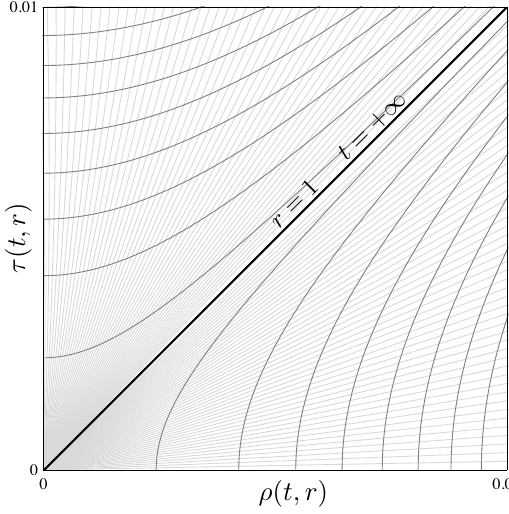
Figure 2 . (cid:28) ( t; r ) and (cid:26) ( t; r ) in units of r g . Lines of constant r are dark gray and lines of constant t are light gray. The horizon is at (cid:28) ( t; r ) = (cid:26) ( t; r ). (cid:12) 1 =(cid:12) 2 is set to 1. at the horizon, i.e., when r = r g and tanh[ t= 2 r g ] = 1. In other words, we are enforcing that the horizon be a null surface in the ( (cid:28); (cid:26) ) coordinates of the reference metric. These two conditions (cid:12)x all integration constants at each order in n . We plot the solution in (cid:12)gure 2. The dark gray lines are lines of constant r and the light gray lines are lines of constant t . The horizon corresponds to (cid:28) = (cid:26) . Outside the horizon, t = 0 corresponds to (cid:28) = 0. However, we note that inside the horizon, t = 0 does not correspond to (cid:26) = 0. Otherwise, these solutions share many similarities